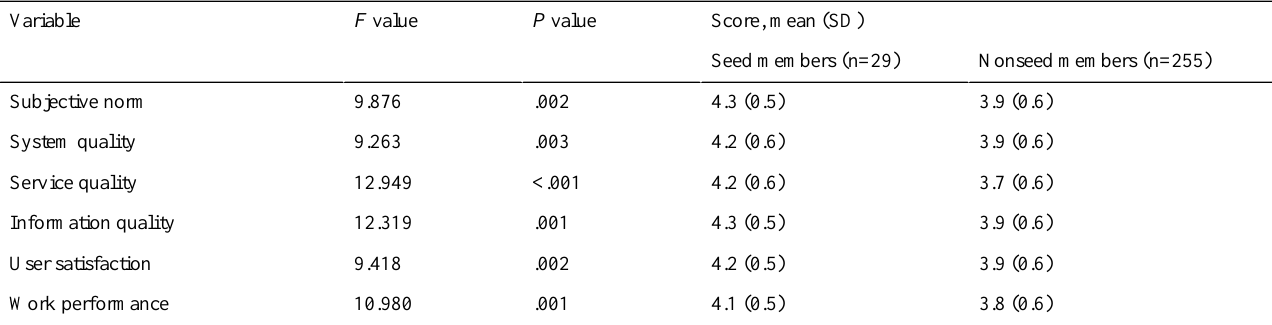
Table 2. Results of analysis of variance and average scores according to whether users served as seed members for promoting nursing informatization.